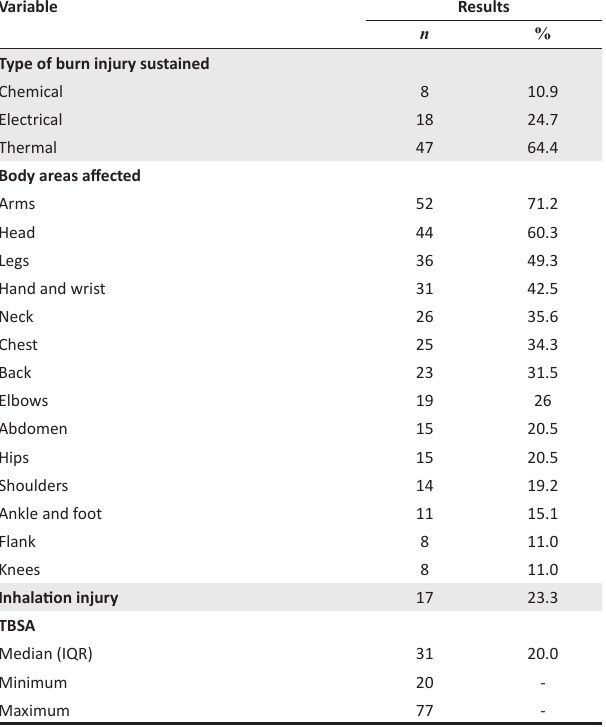
TABLE 2: Burn characteristics of patients admitted with major burn injury ( n =